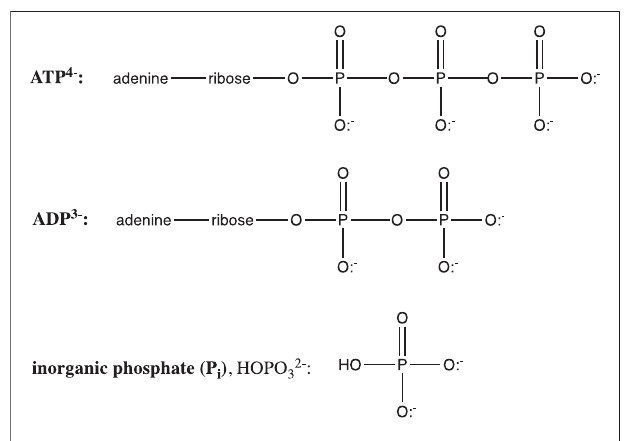
FIGURE 7 | Structures of ATP, ADP, and inorganic phosphate.